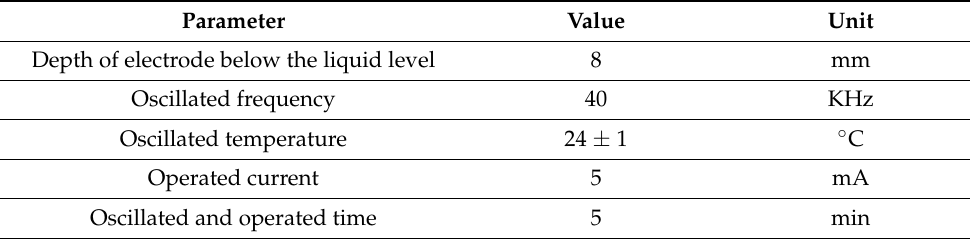
Table 2. Parameters for sonoelectrochemistry fabrication. Parameter Value Unit Depth of electrode below the liquid level 8 mm Oscillated frequency 40 KHz Oscillated temperature 24 ± 1 ◦ C Operated current 5 mA Oscillated and operated time 5